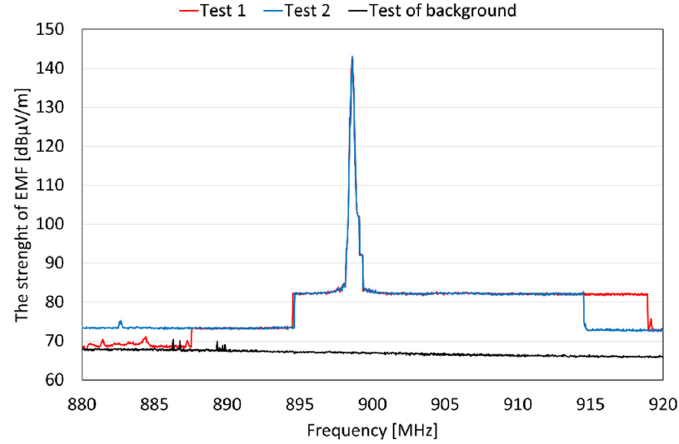
Figure 3. Measurement results of electromagnetic field strength generated from a device built on Arduino UNO at a distance of 2.5 cm.